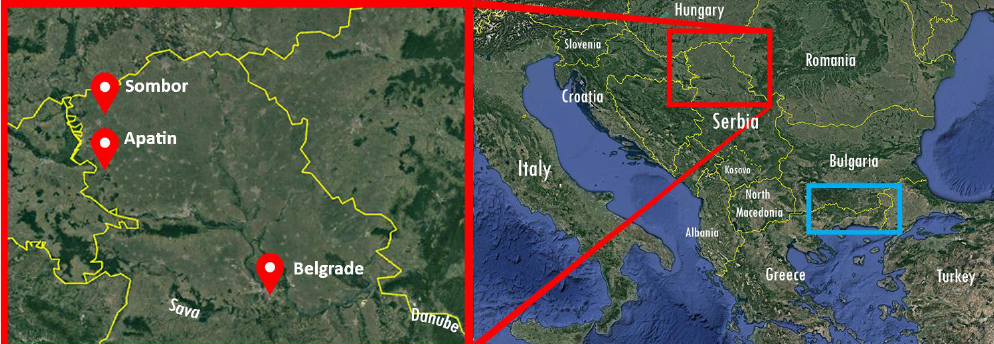
Figure 1. Map of the north of Serbia ( left ) with red pins indicating mosquito-sampling sites where the Xanthi chryso-like virus (XCLV) was detected (GPS coordinates of the sites are 44°85′07″ N, 20°46′97″ E; 45°76′29″ N, 19°08′47″ E; 45°66′58″ N, 18°97′98″ E). Area marked in blue ( right ) designates the geographic area where XCLV was first described by Konstantinidis and coworkers [13].